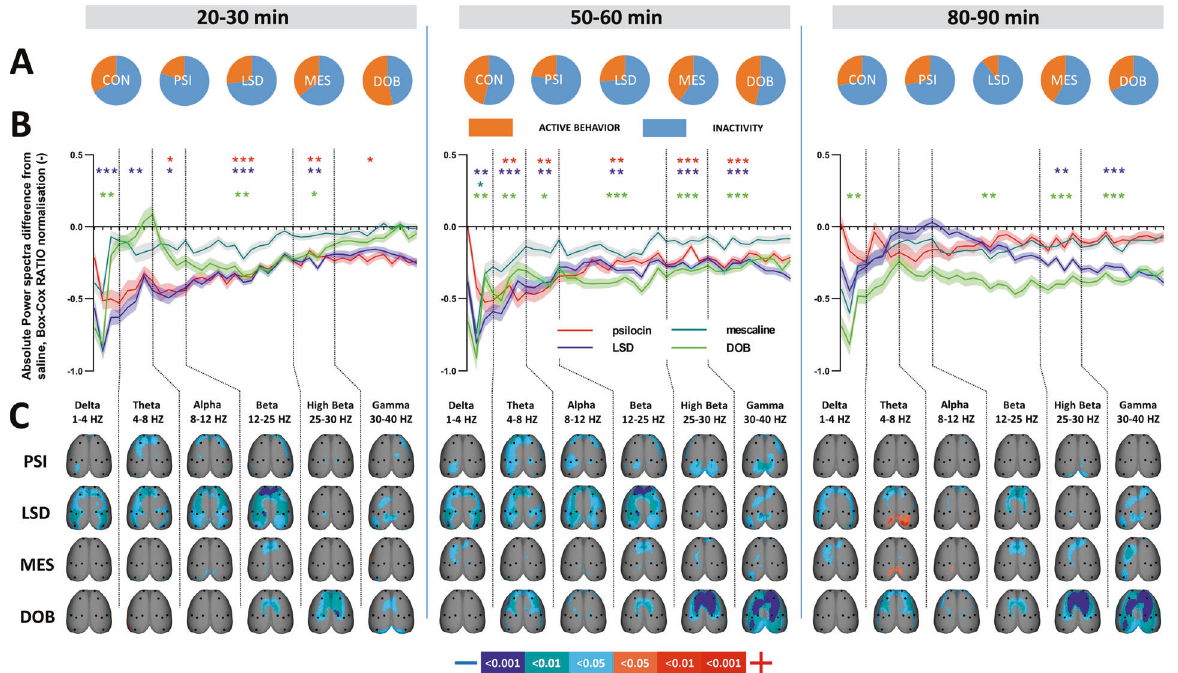
Fig. 2 The effects of treatments on EEG power spectra in three time epochs. The abbreviations are given as follows: CON (control group, saline 2 ml/kg), PSI (psilocin, 4 mg/kg), LSD (lysergic acid diethylamide 0.2 mg/kg), MES (mescaline 100 mg/kg), DOB 5 (2,5-dimethoxy-4- bromoamphetamine, 5 mg/kg). A Pie charts depicting behavioral activity — average time the rats spent active (orange) and inactive (blue). B Mean values of absolute EEG power spectra difference against the control group normalized by the Box-Cox method for all substances over consecutive time epochs; the x axis shows the frequency in Hz, the y axis the dimensionless quantity. The level of signi fi cance is indicated as *P < 0.05, ** P < 0.01, *** P < 0.001. Lines show the mean values, shaded error bars correspond to standard error mean values. C EEG topographic maps of absolute power spectra differences — all treatments against the control group, drugs in rows, frequency bands in columns; only a signi fi cant change is displayed. The direction of change is indicated by a change in color — decreases in blue, increases in red. The level of signi fi cance is indicated by a three-level-scaled color spectrum, see the legend. Corresponding legends are at the bottom of each